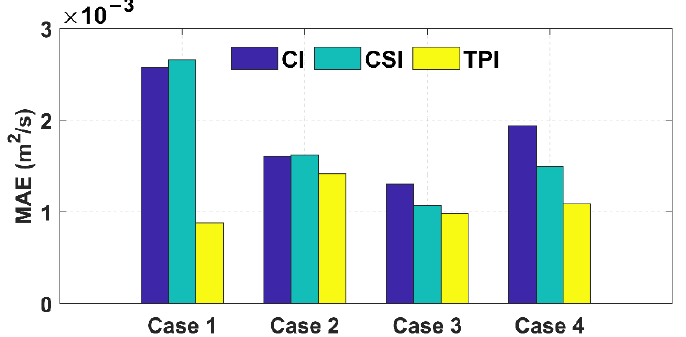
Figure 2. The MAEs between the prescribed and inverted VEVCs with three schemes in Cases 1 –